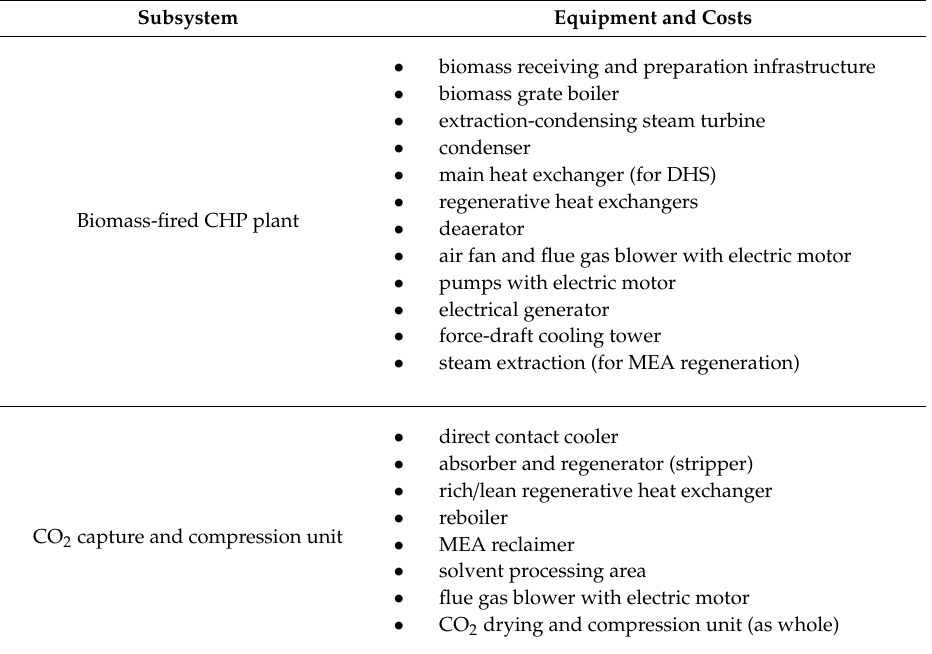
Table 4. List of equipment considered in the investment cost assessment (MEA: monoethanolamine; sCO 2 : supercritical CO 2